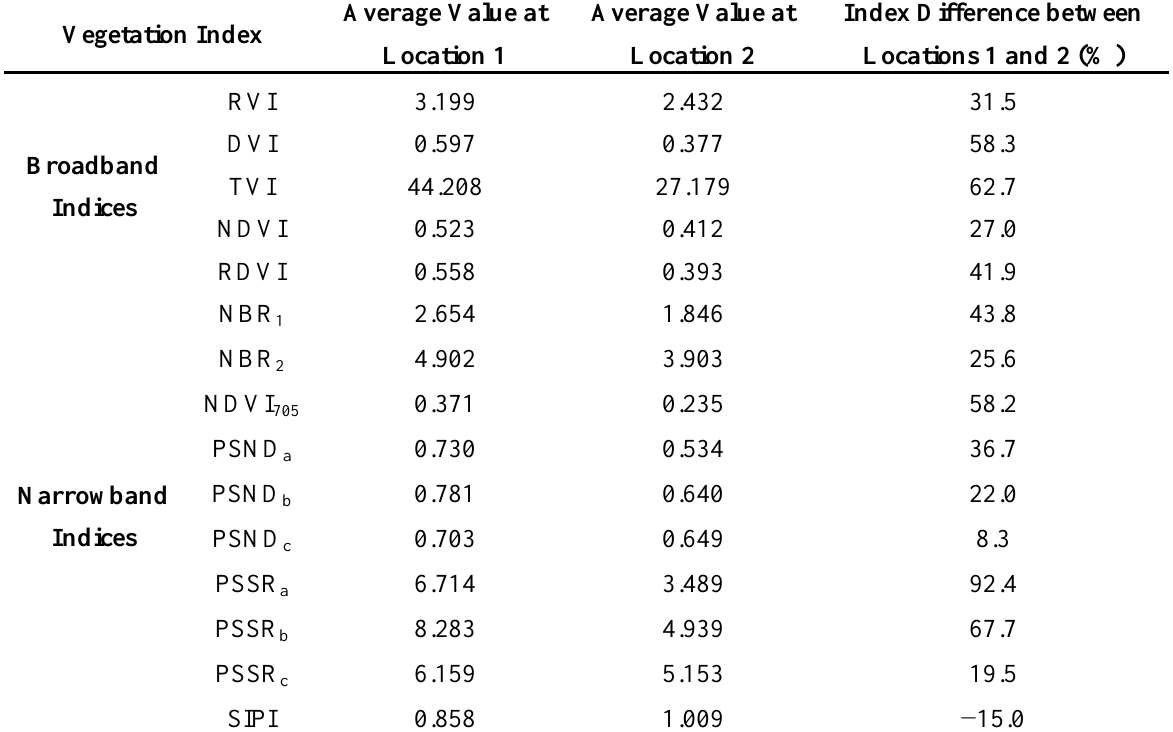
Table 5. Vegetation index average values and differences between Locations 1 and